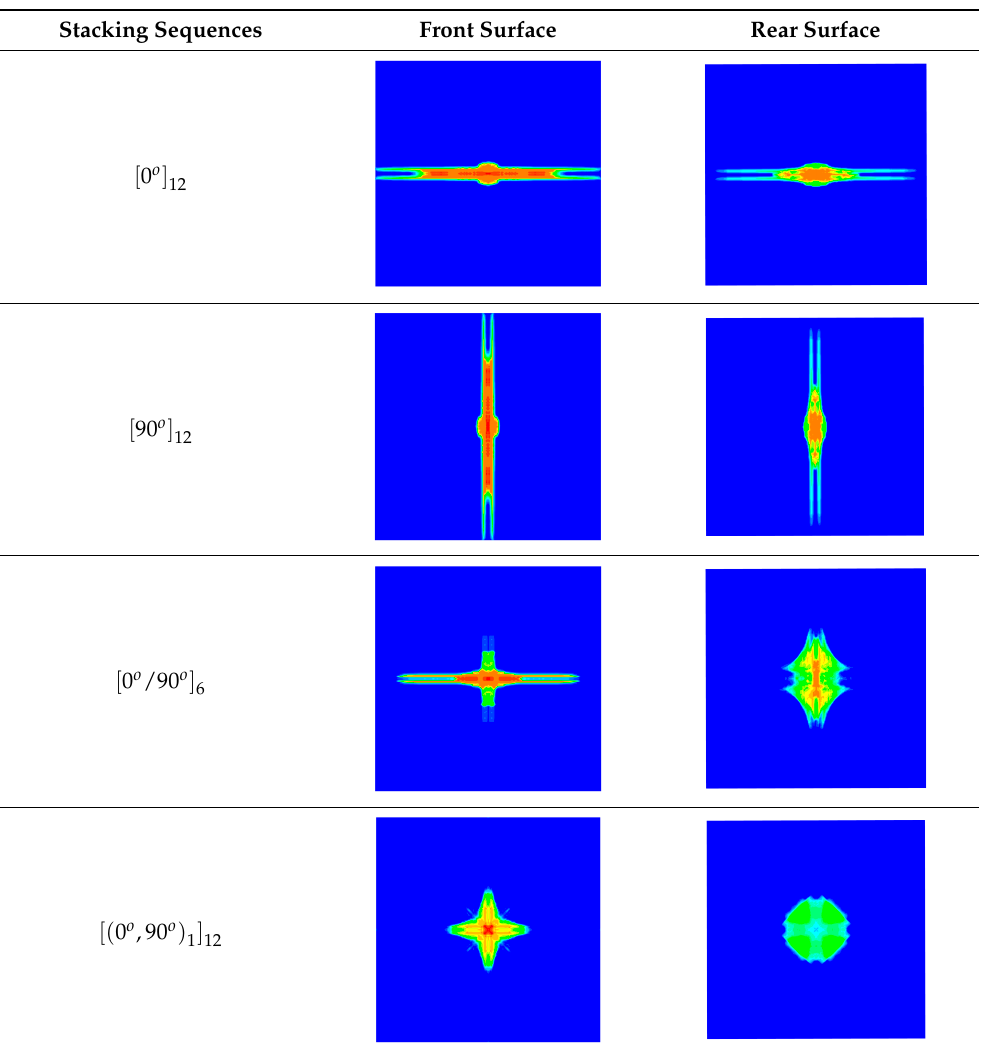
Table 6. Damage of the laminates with different stacking sequences.